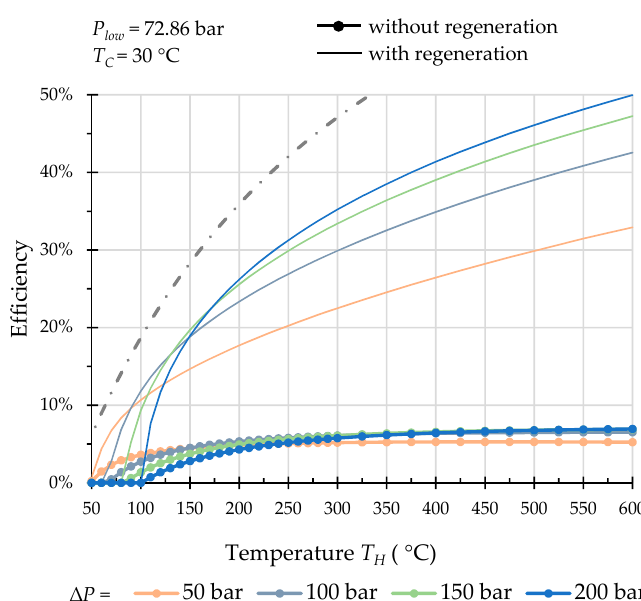
Figure 13. Efficiency of regenerative Bush-type machine operated with carbon dioxide in high temperature range.